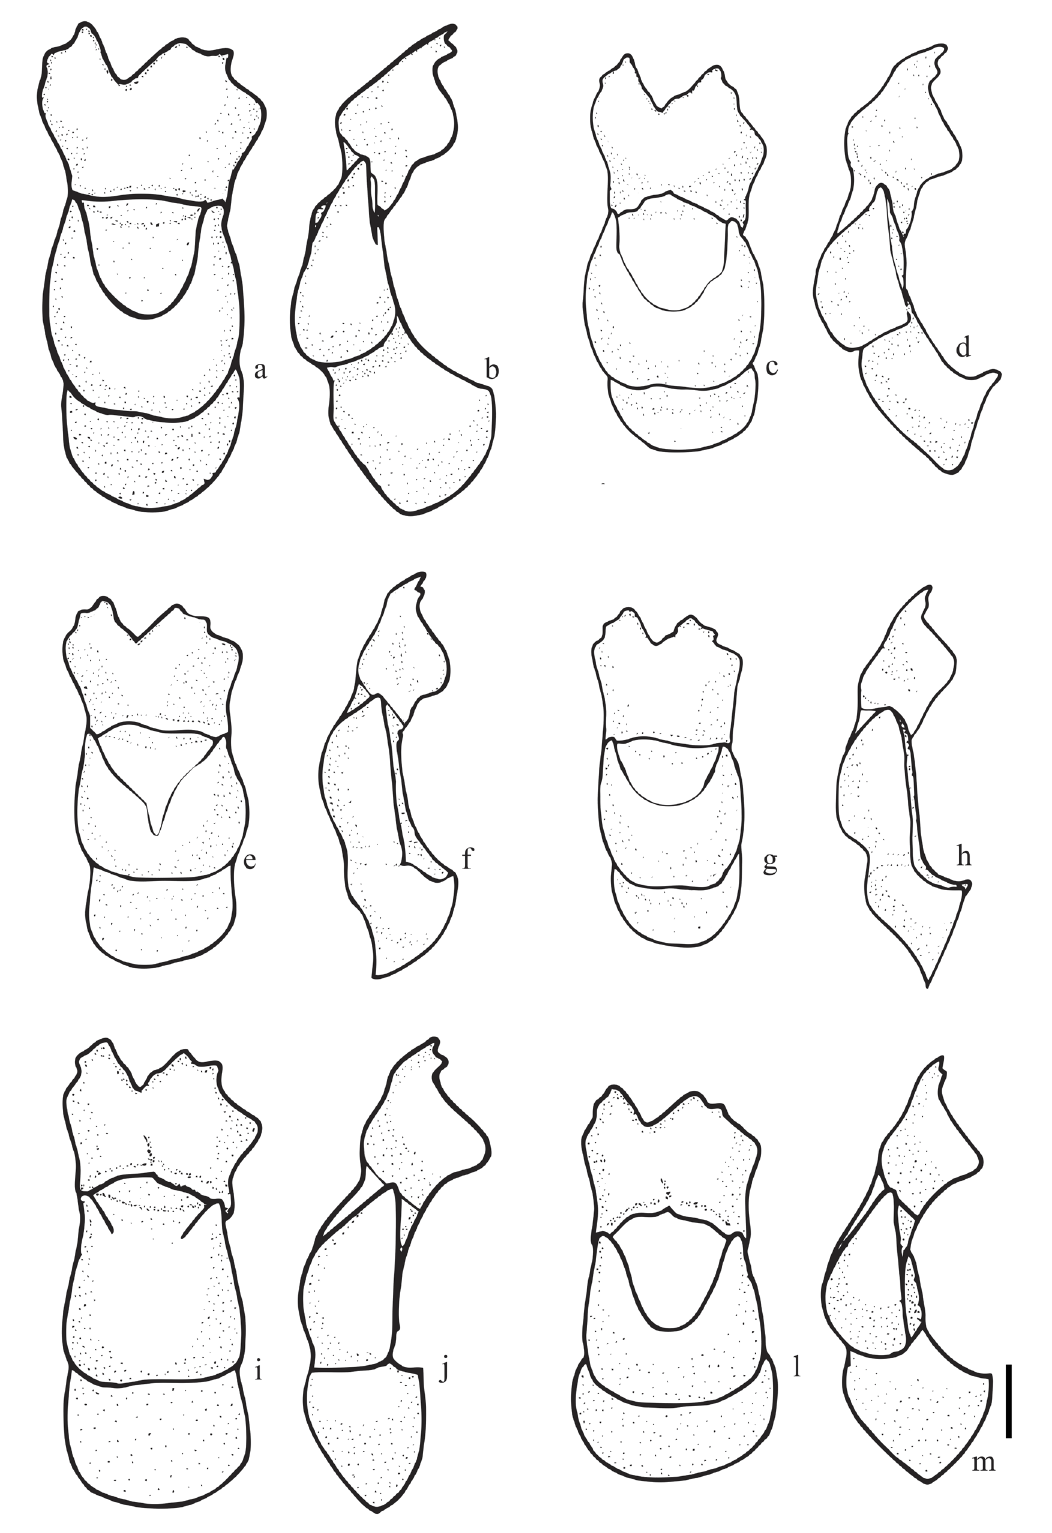
Fig. 7. Variation in male genitalia. a–d . Oplognathus kirbii MacLeay, 1819 (a-b: CEMT; c-d: ZMHB). e–h . O. helmenreichi Ohaus, 1905 (ZMHB). i–m . O. bahianus Ohaus, 1912 (CERPE). Scale bar = 1